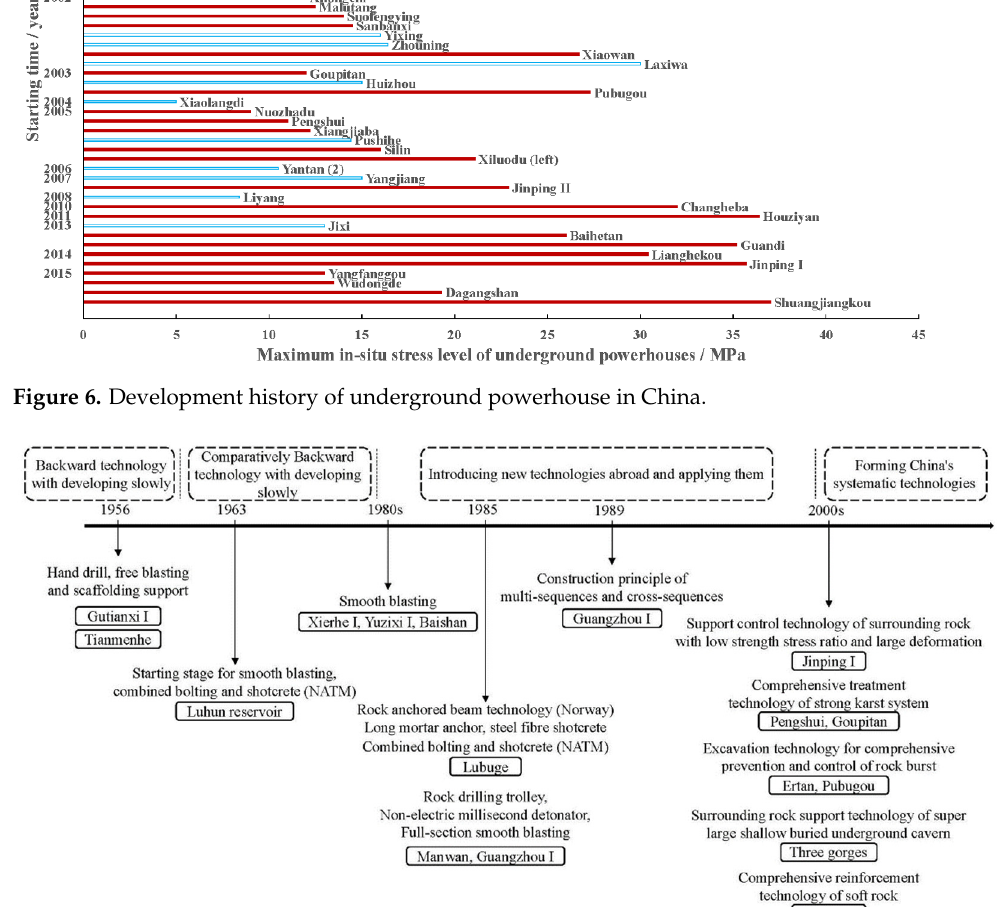
Figure 6. Development history of underground powerhouse in China.